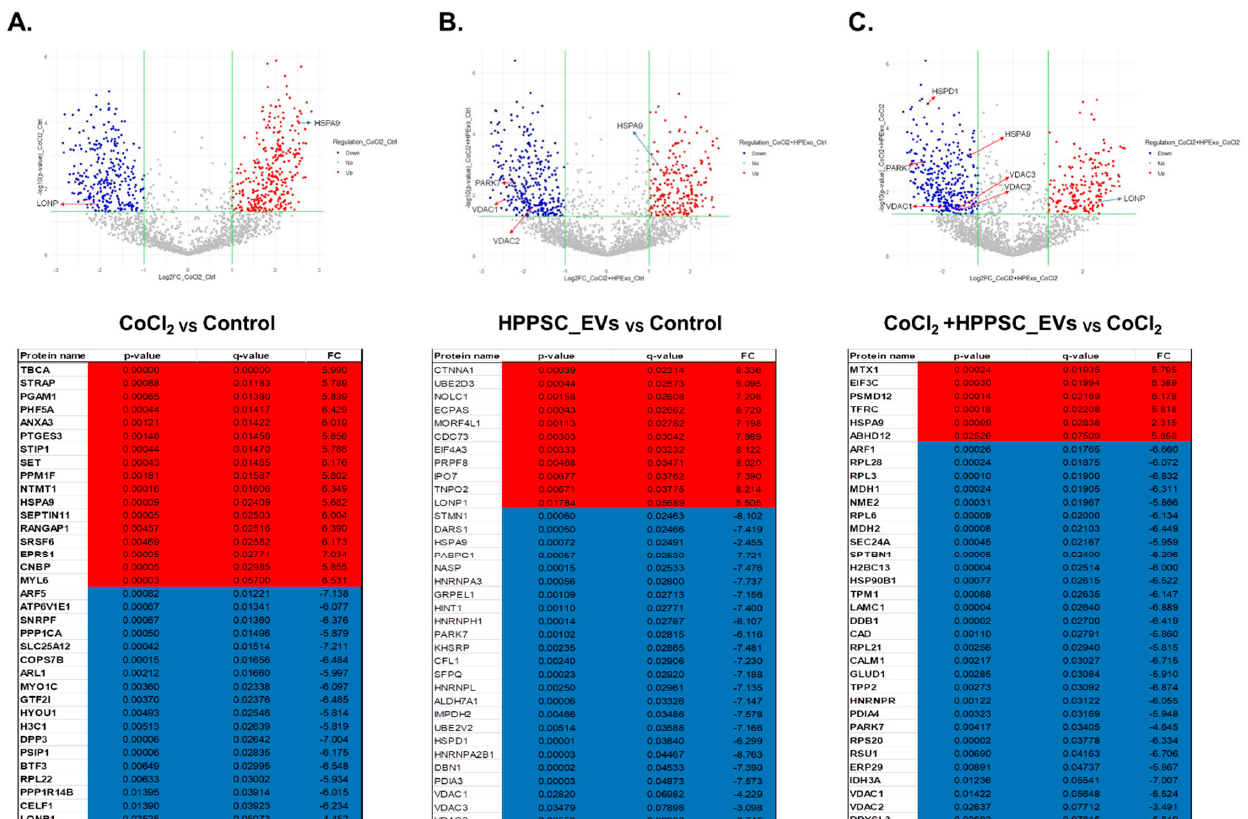
Figure 3. Identification of up/down ‐ regulated DEPs in each group. Volcano plot of DEPs of each group. Red dots described up ‐ regulated proteins and blue dots present down ‐ regulated proteins. Proteins with significantly different expressions were presented.